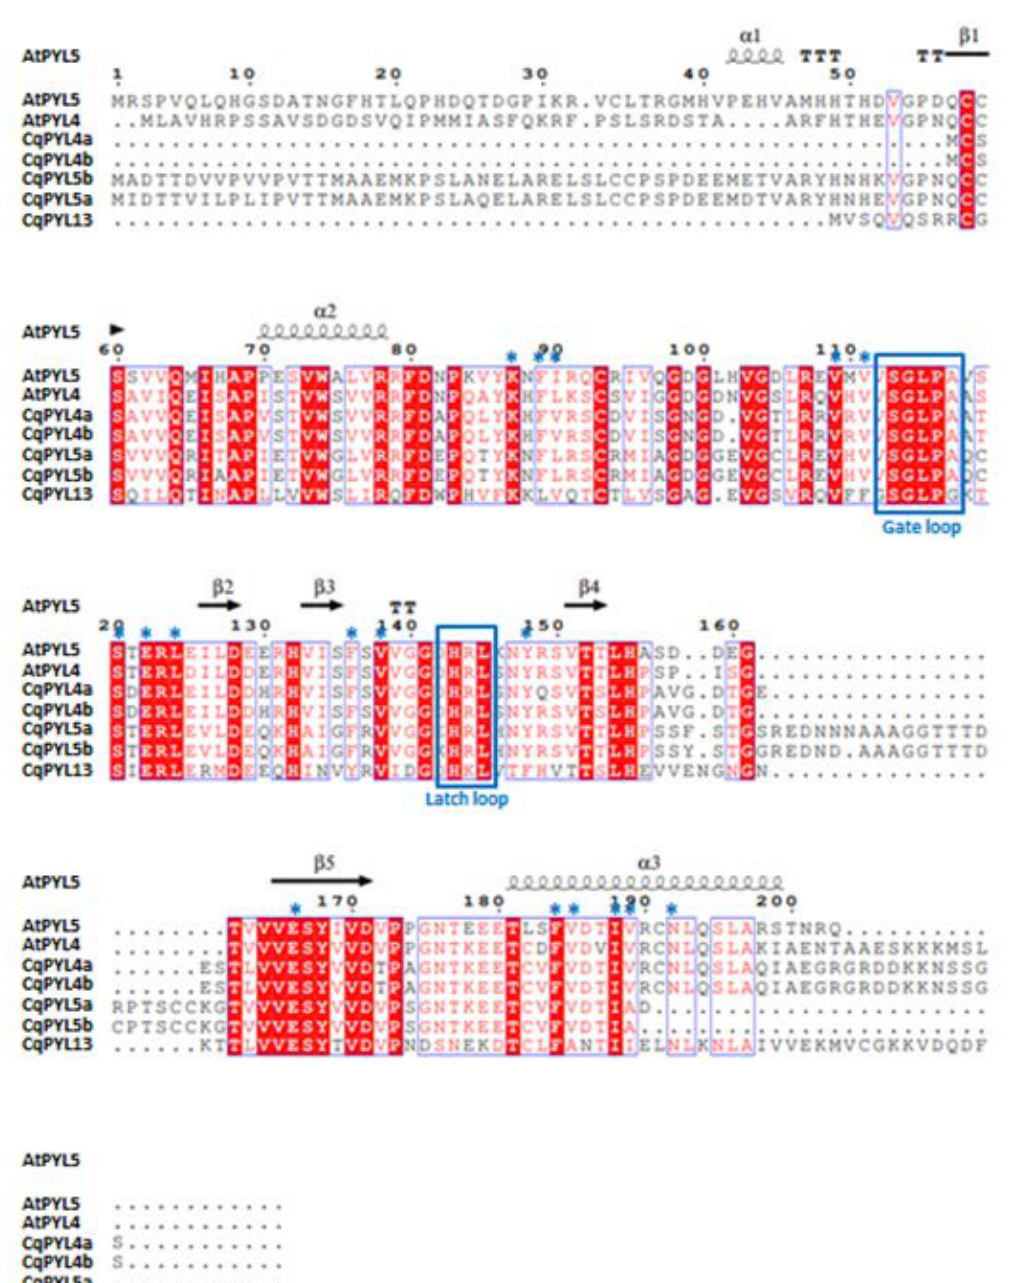
Figure 7. Amino acid sequence alignment of At and Nb sub-family II members of ABA receptors. Sequence and secondary structure alignment of ABA receptors are indicated. The secondary structure of the NbPYLs is predicted according to the crystallographic structure of AtPYL5 (Protein DataBank Code 4jdl), and was generated using the ESPRIPT tool [36]. Blue boxes indicate the position of the gate and latch loops. Blue asterisks mark residues involved in interactions with